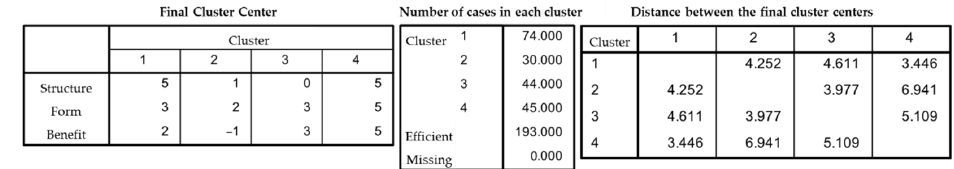
Figure A3. K ‐ means clustering analysis of historical buildings after renovation. Figure A3. K-means clustering analysis of historical buildings after